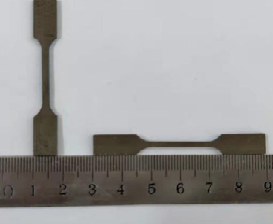
Figure 10. SLM-formed porous Ti6Al4V alloy tensile test specimen.